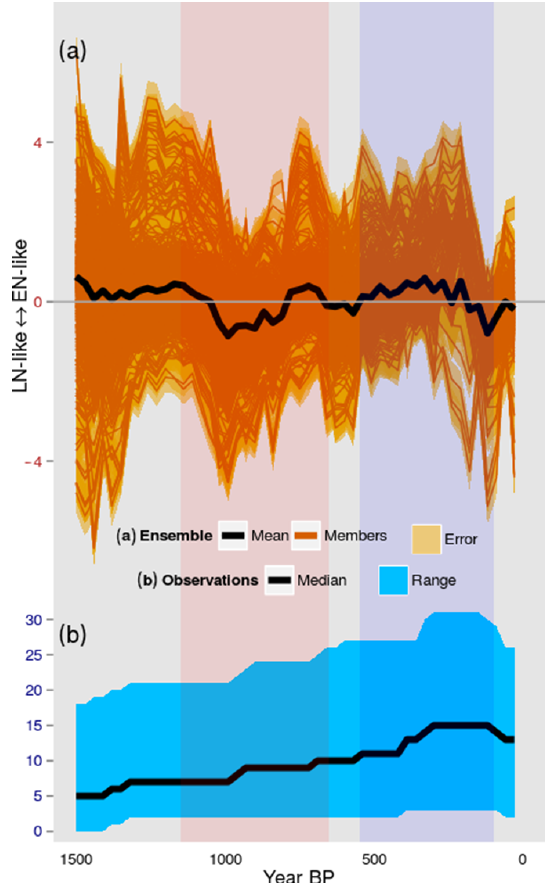
Figure 2. Precipitation ENSO ensembles. (a) Precipitation recon- struction of ENSO-like climate change that has been 30-year aver- aged (black line). Individual network solutions are shown as orange lines, with the uncertainty envelope in orange shading. (b) Number of proxies included in the ensemble over time, with the median in black and the range in blue. The pink and purple shaded periods are the MCA and LIA